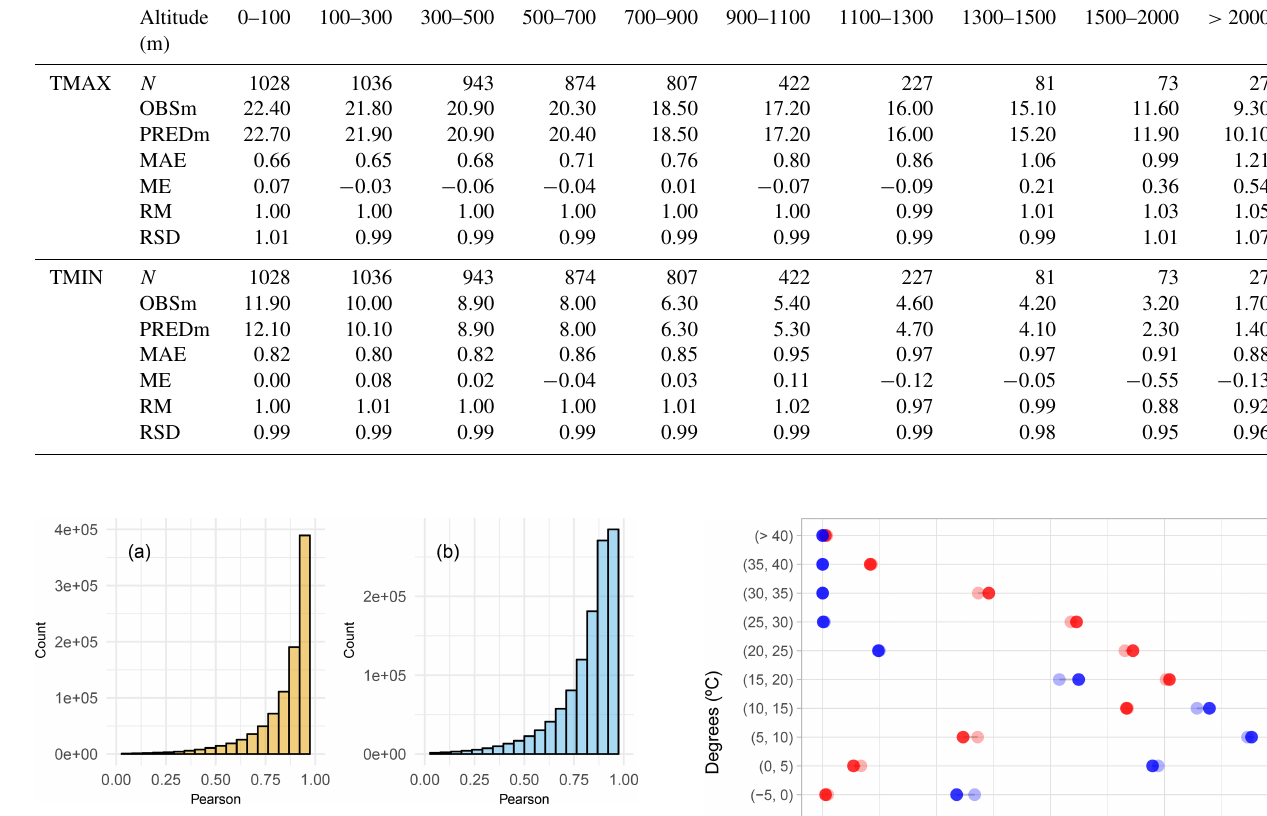
Figure 8. Correlation frequencies between daily observations and estimates, by month, in the final dataset. Maximum (orange) and minimum (blue) temperatures are shown.